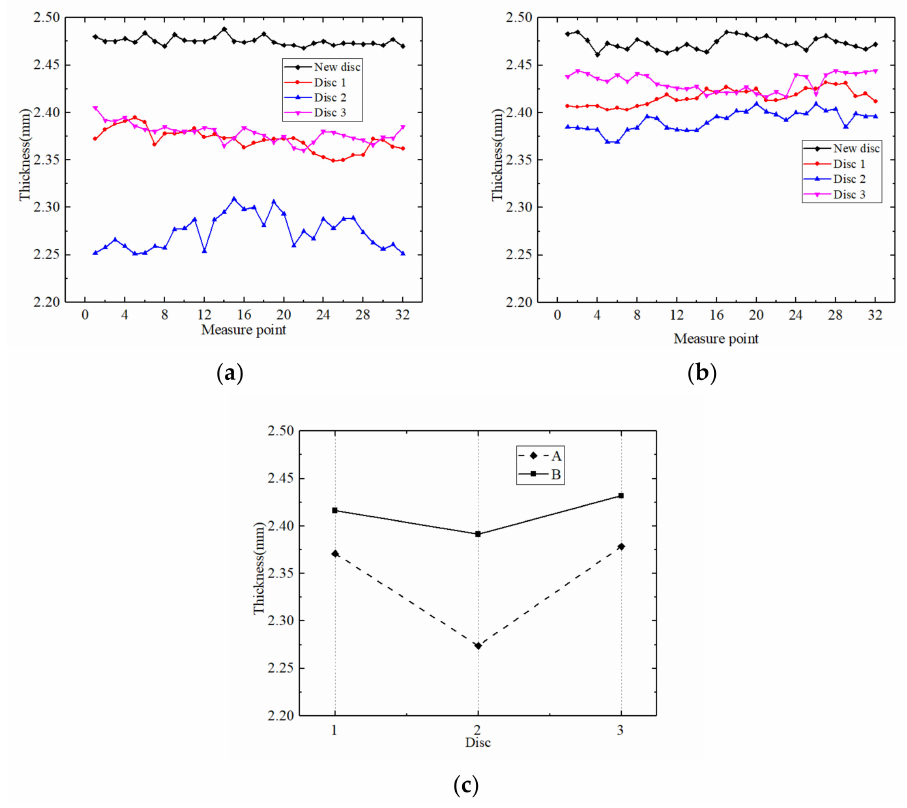
Figure 15. The thickness of the friction disc after the test: ( a ) thickness of different discs in A; ( b ) thickness of different discs in B; ( c ) mean thickness of A and